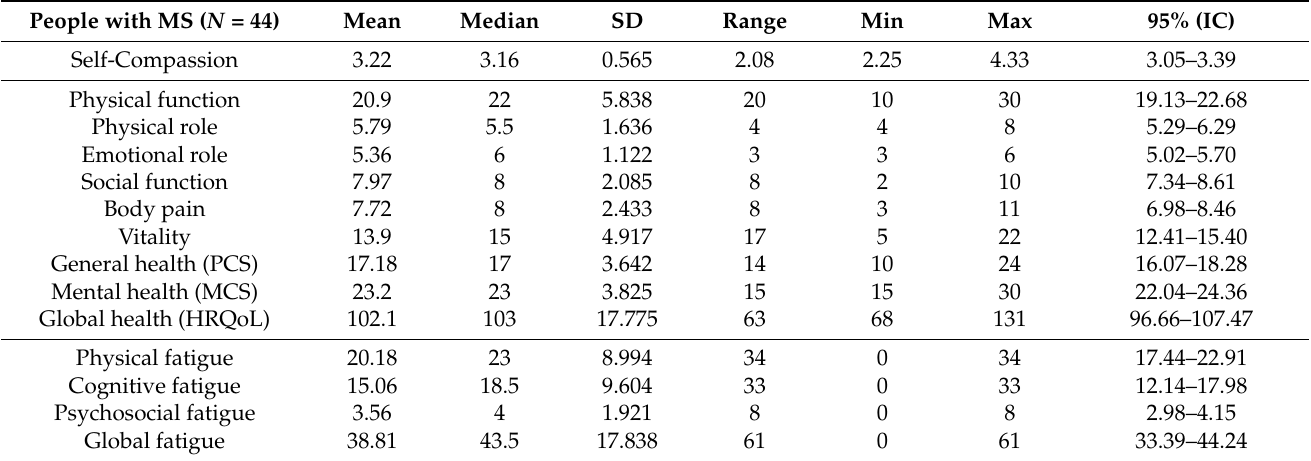
Table 2. Descriptive statistics of self-compassion, health, and fatigue variables in people with